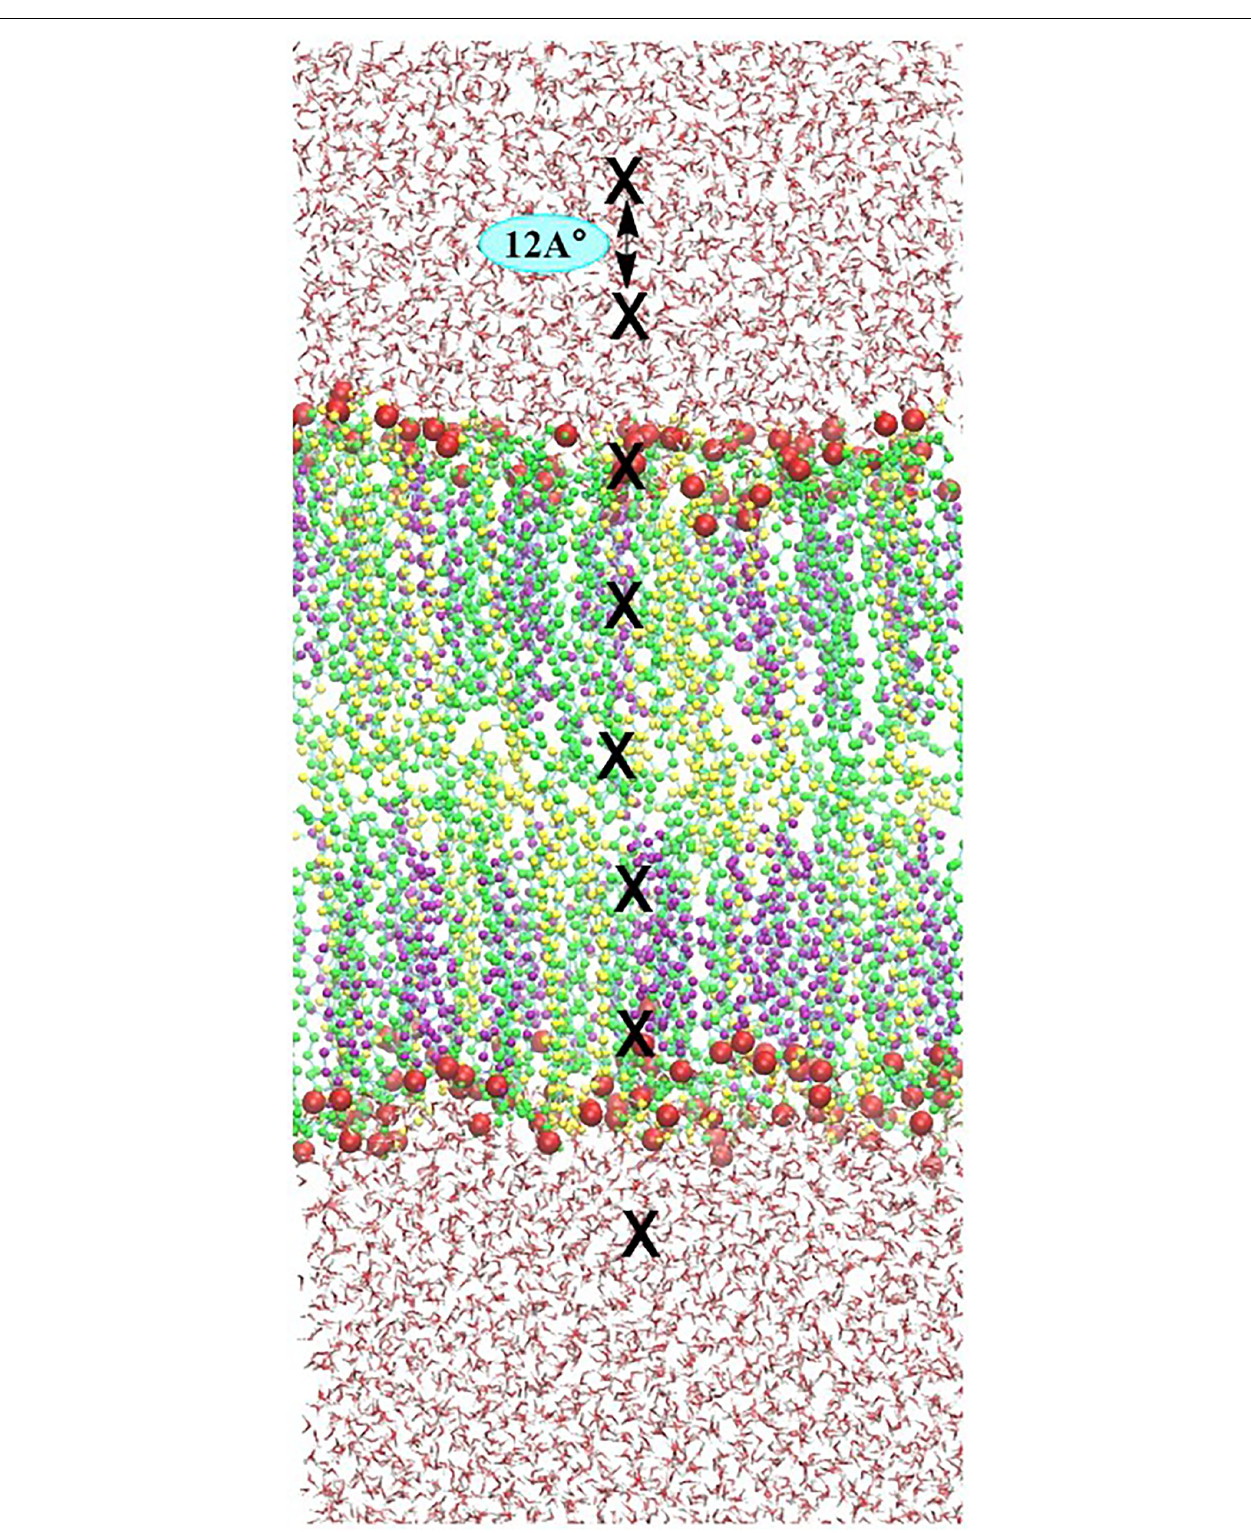
Frontiers in Pharmacology |